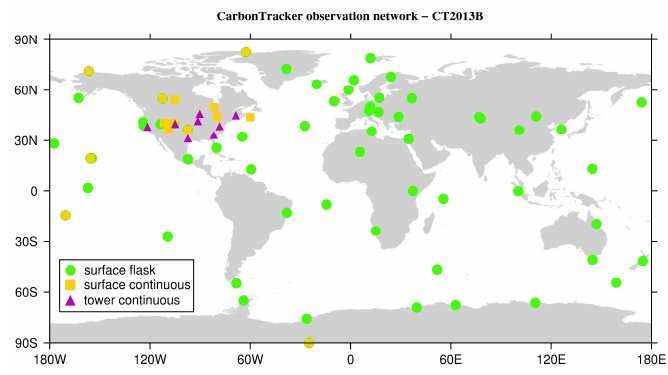
Figure 6. The spatial distribution of CT2013B assimilated observational network (source: CarbonTracker website).